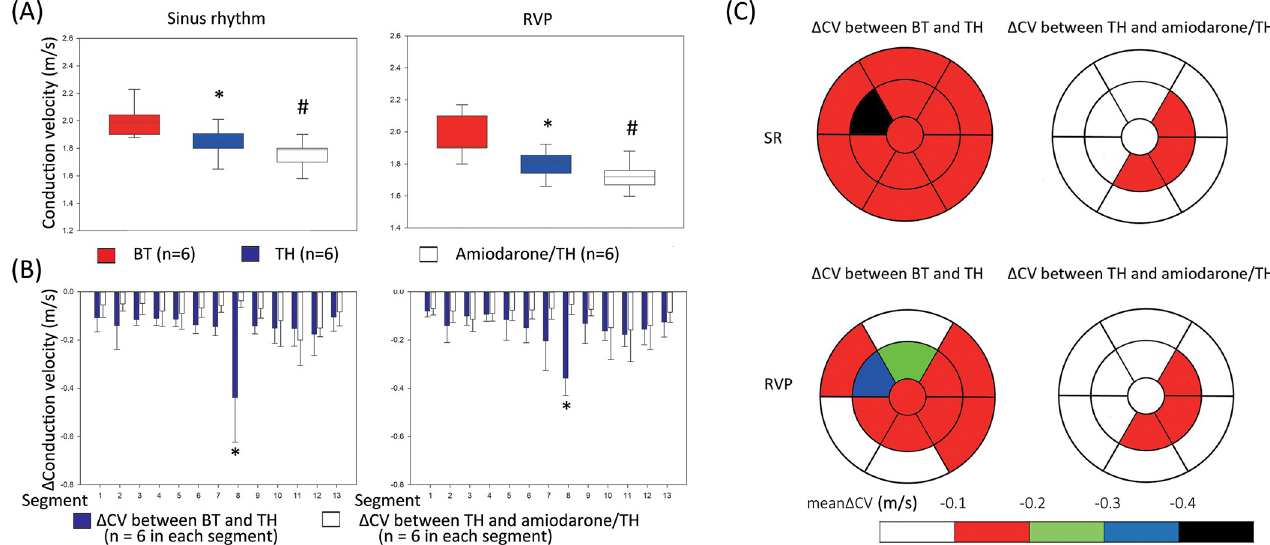
Fig 3. Global and regional changes in the CV. (A) Sequential changes in the CV after TH or amiodarone treatment during SR or RVP. A sequential reduction in the CVs was observed after TH and amiodarone treatment. These data were derived from all the six pigs from this study. * P < 0.05, BT vs. TH; # P < 0.05, TH vs. Amiodarone/TH, both by the paired t-test. (B) Interval changes between BT and TH ( Δ CV between BT and TH) and between TH and amiodarone/TH ( Δ CV between TH and amiodarone/TH) in the different epicardial segments. These data were derived from all the six pigs from this study. The interval changes in the CV in segment 8 (anterior mid right ventricle) were significantly greater than those in all the other segments. * P < 0.05, Δ CV between BT and TH in segment 8 vs. the other segments in the post-hoc analysis with the Bonferroni method. (C) The color-coded polar map of the interval changes between BT and TH ( Δ CV between BT and TH) and between TH and amiodarone/TH ( Δ CV between TH and amiodarone/TH) in the different epicardial segments. Each color indicated different degree of decrease in the CV.